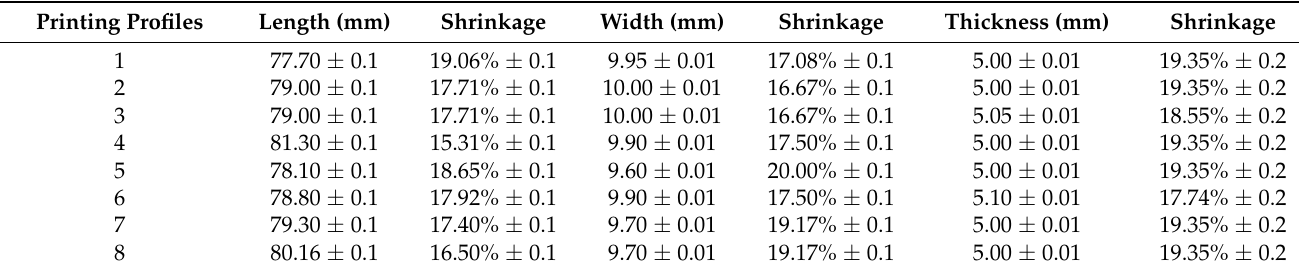
Table 6. Dimensions and shrinkages of the sintered bending